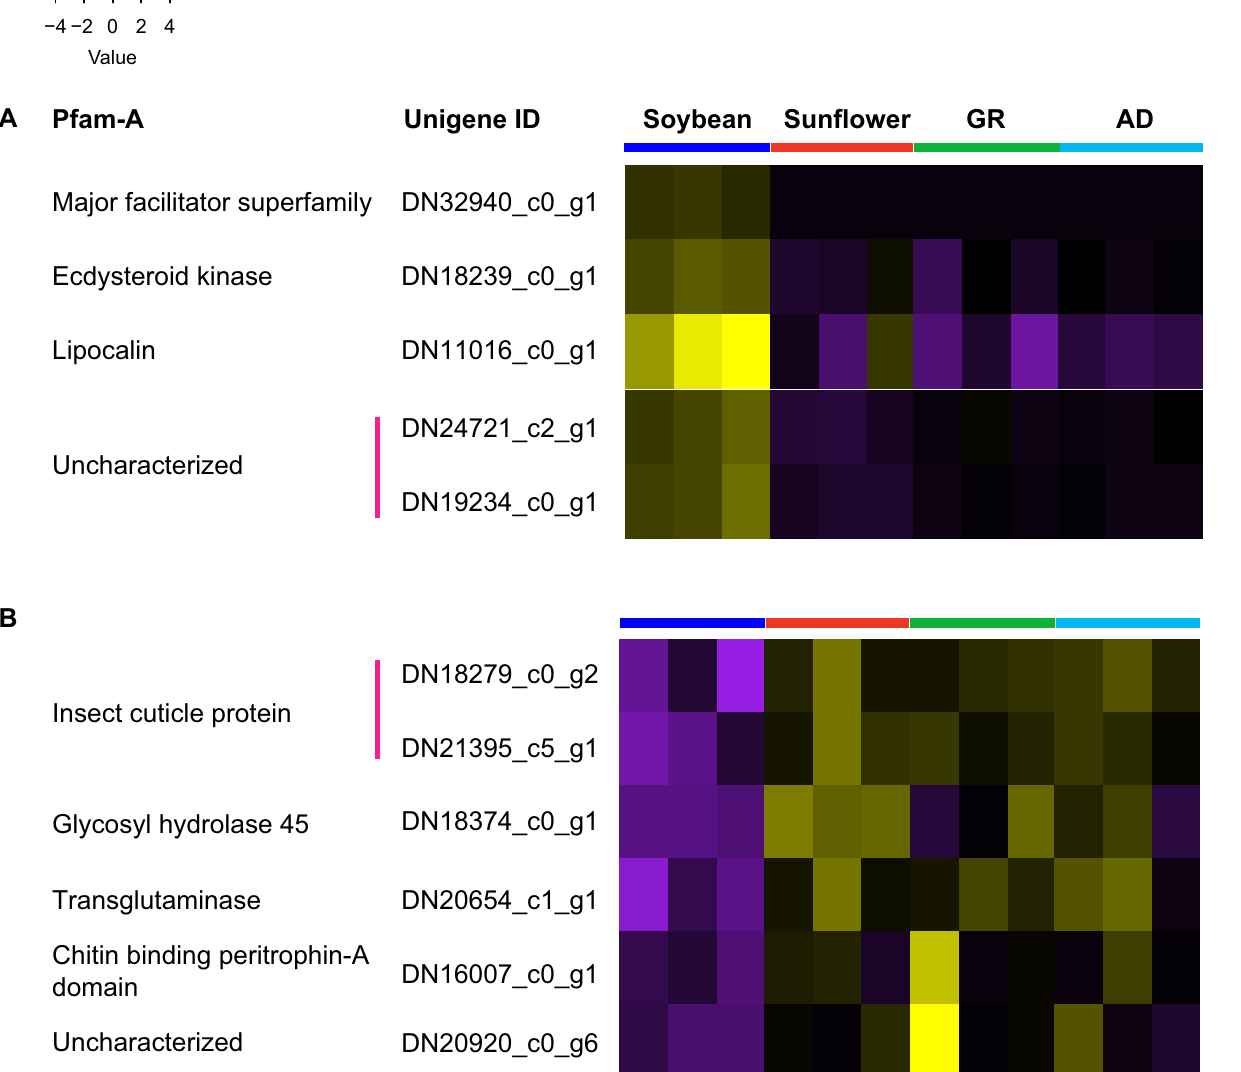
Figure 2. Heatmap of commonly ( A ) up-regulated and ( B ) down-regulated unigenes in Dectes texanus larvae fed soybean compared to those fed sunflower, giant ragweed (GR) and artificial diet (AD). Each row represents an individual unigene. Yellow and purple indicate high and low expression levels, respectively (Fold change > ± 1.5, False Discovery Rate < 0.05). Pfam-A = Protein family-A domain; MFS = Major facilitator